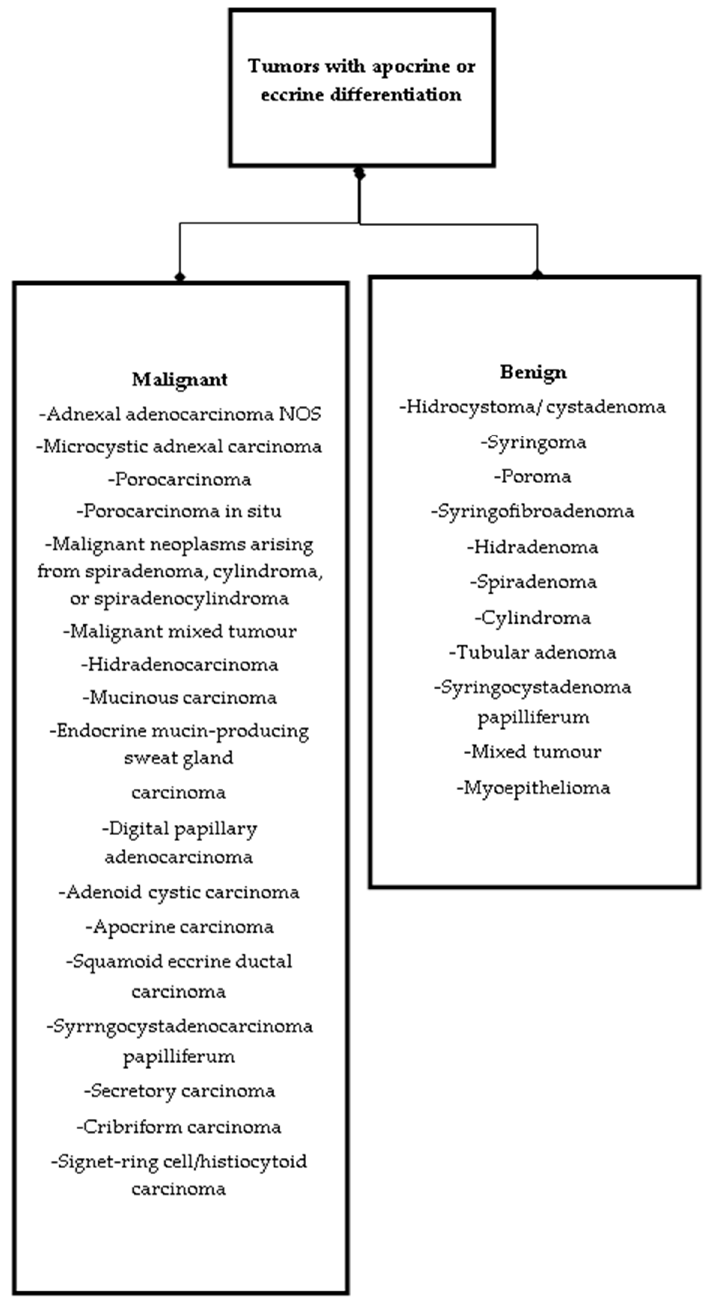
Figure 1. Division of tumors with apocrine and eccrine differentiation.